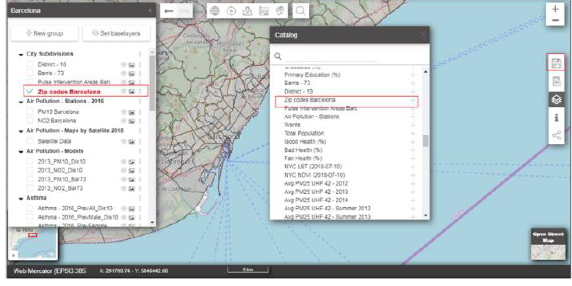
Figure 17. A layer is added to the existing map